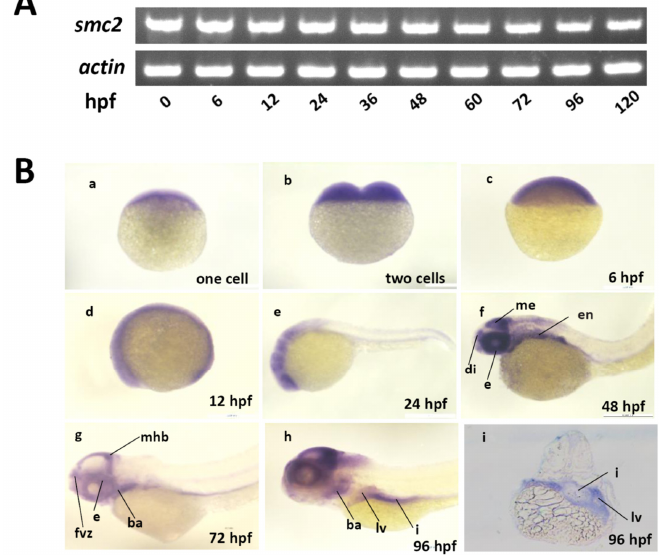
Figure 1. Expression of SMC2 mRNA during zebrafish embryogenesis. ( A ) Expression levels of SMC2 at different stages were analyzed with RT-PCR and the expression of β -actin served as the control. ( B ) Detection of SMC2 transcripts during embryogenesis with WISH. hpf, hours post-fertilization; me, mesencephalon; di, diencephalon; fvz, forebrain ventricular zone; ba, branchial arches; mhb, midbrain–hindbrain boundary; i, intestine; en, endoderm; e, eye; lv, liver.